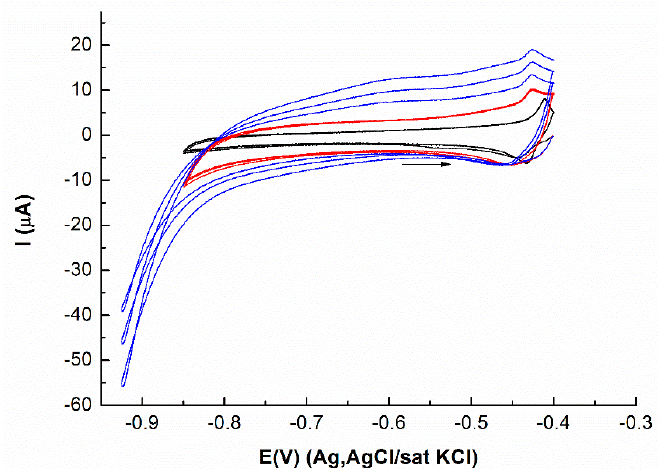
Figure 6 . Consecutive cyclic voltammograms of pH 9.2 ammonia buffer solution (black curves) and 7 mM MoO 42 − in a pH 9.2 ammonia buffer solution (red and blue curves, respectively) on Se ad /Ag(111). The scan rate is 50 mV·s − 1 .